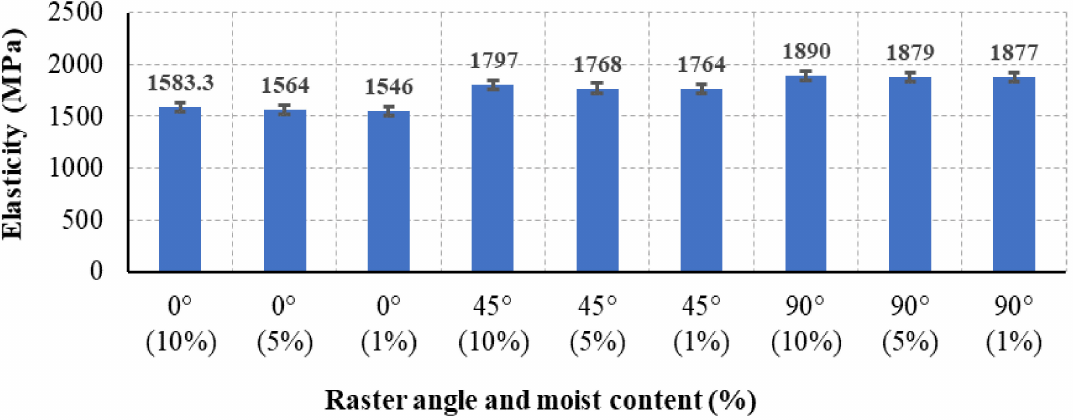
Figure 9. Elasticity in (MPa) for all specimens with different raster angles and moisture content